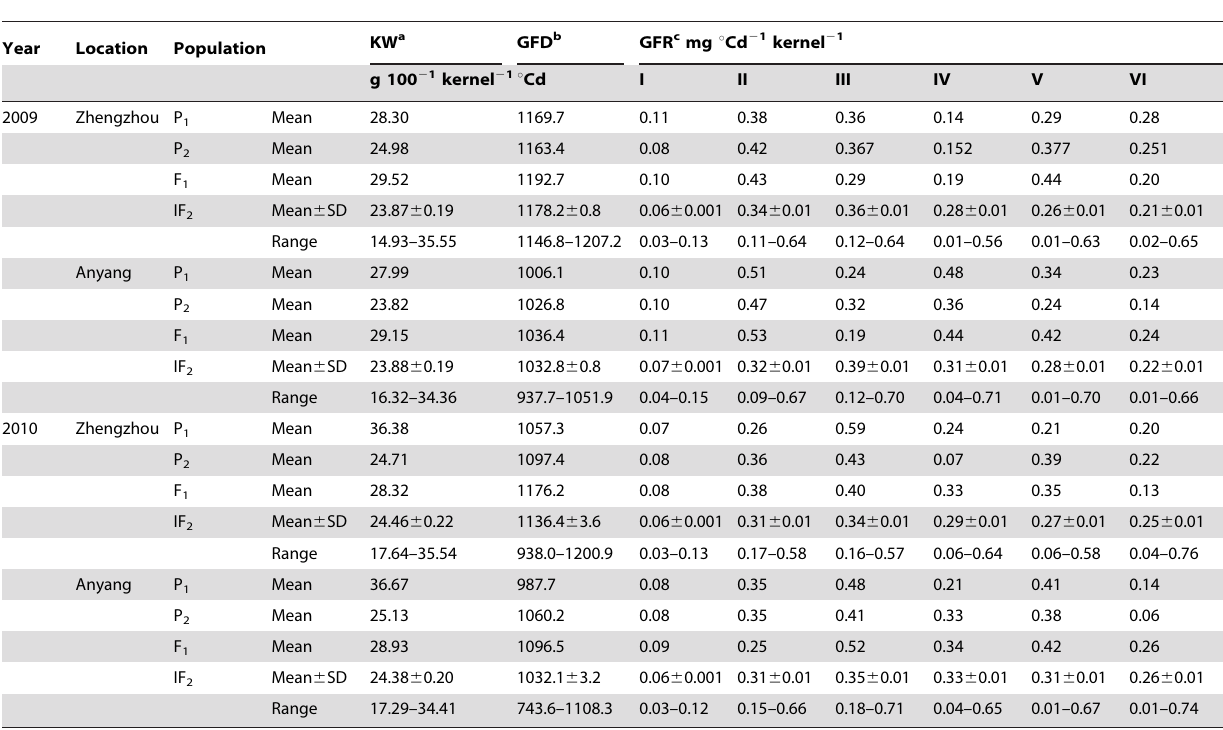
Table 1. Performance of grain filling rate, grain filling duration and final kernel weight in the immortalized F 2 population at two locations.